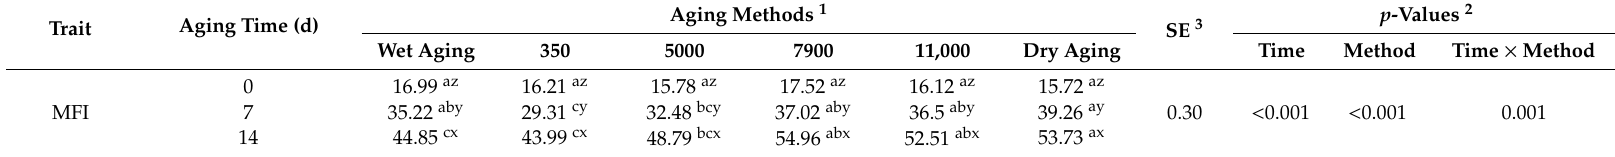
Table 5. E ff ects of di ff erent aging methods and aging time on the myofibrillar fragmentation index (MFI) of beef.